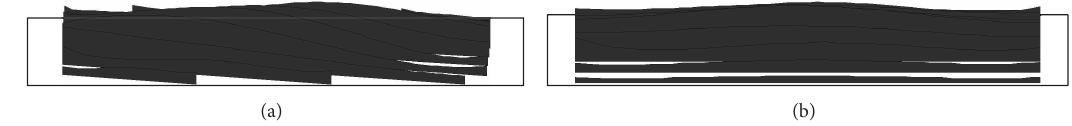
Figure 4: Load distribution on the tooth surface. Illustration of (a) I-stage helical gear pairs and (b) II-stage spur gear pairs.